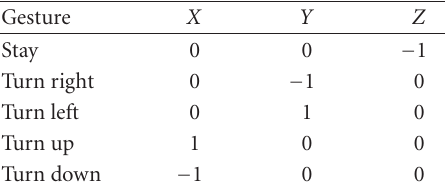
Table 1: Mapping between gestures and